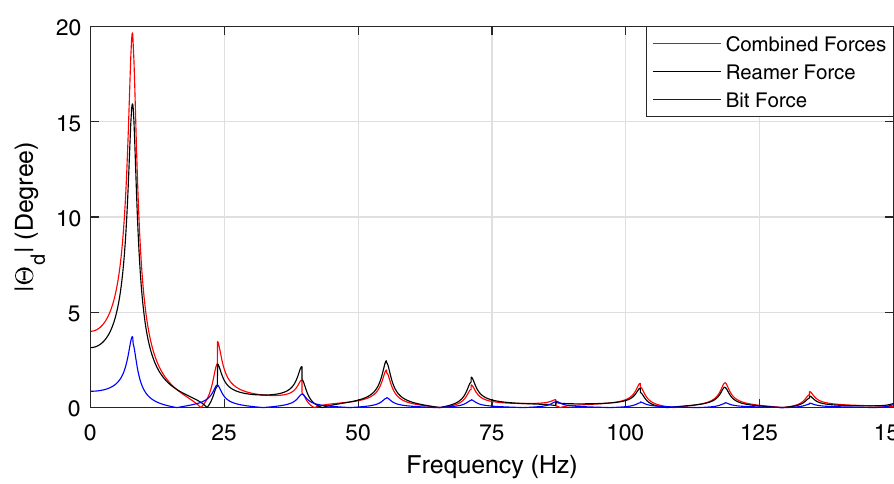
Fig. 5 Frequency response magnitude due to torque at the bit, torque at the reamer, and combined torques of the bit and the reamer